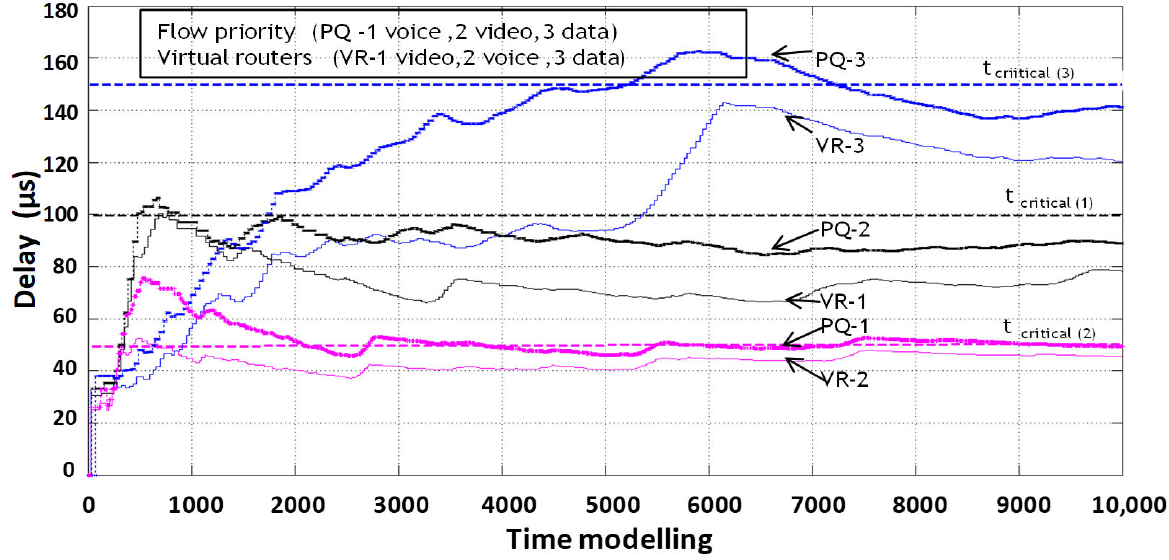
Figure 17. Comparison of packet delay times in a router with prioritized service and with dynamic virtualization of network device